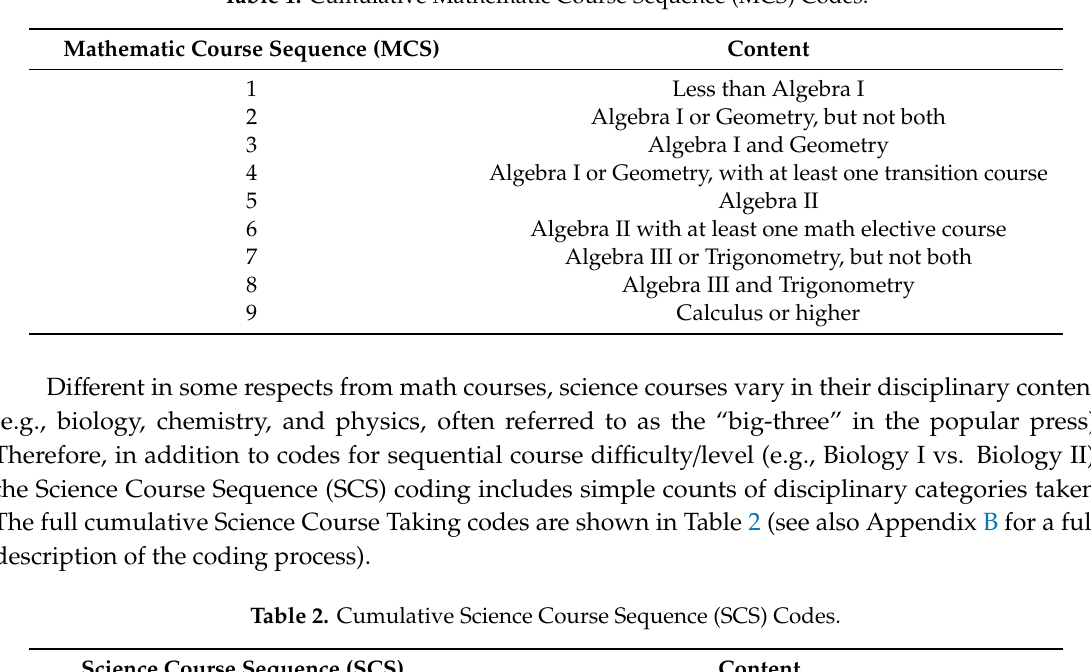
Table 1. Cumulative Mathematic Course Sequence (MCS) Codes.